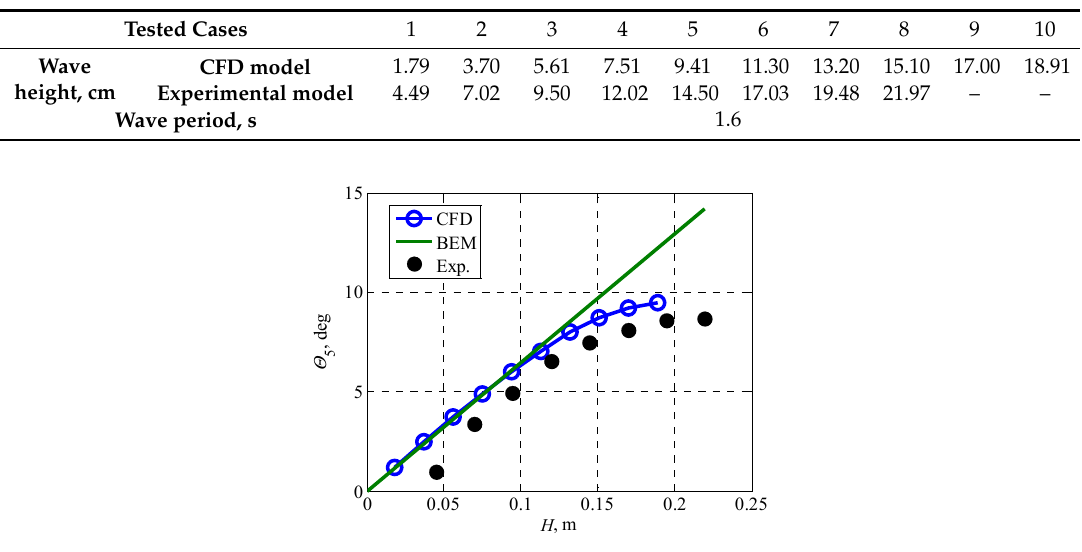
Table 2. Test cases for the comparison in di ff erent wave heights.